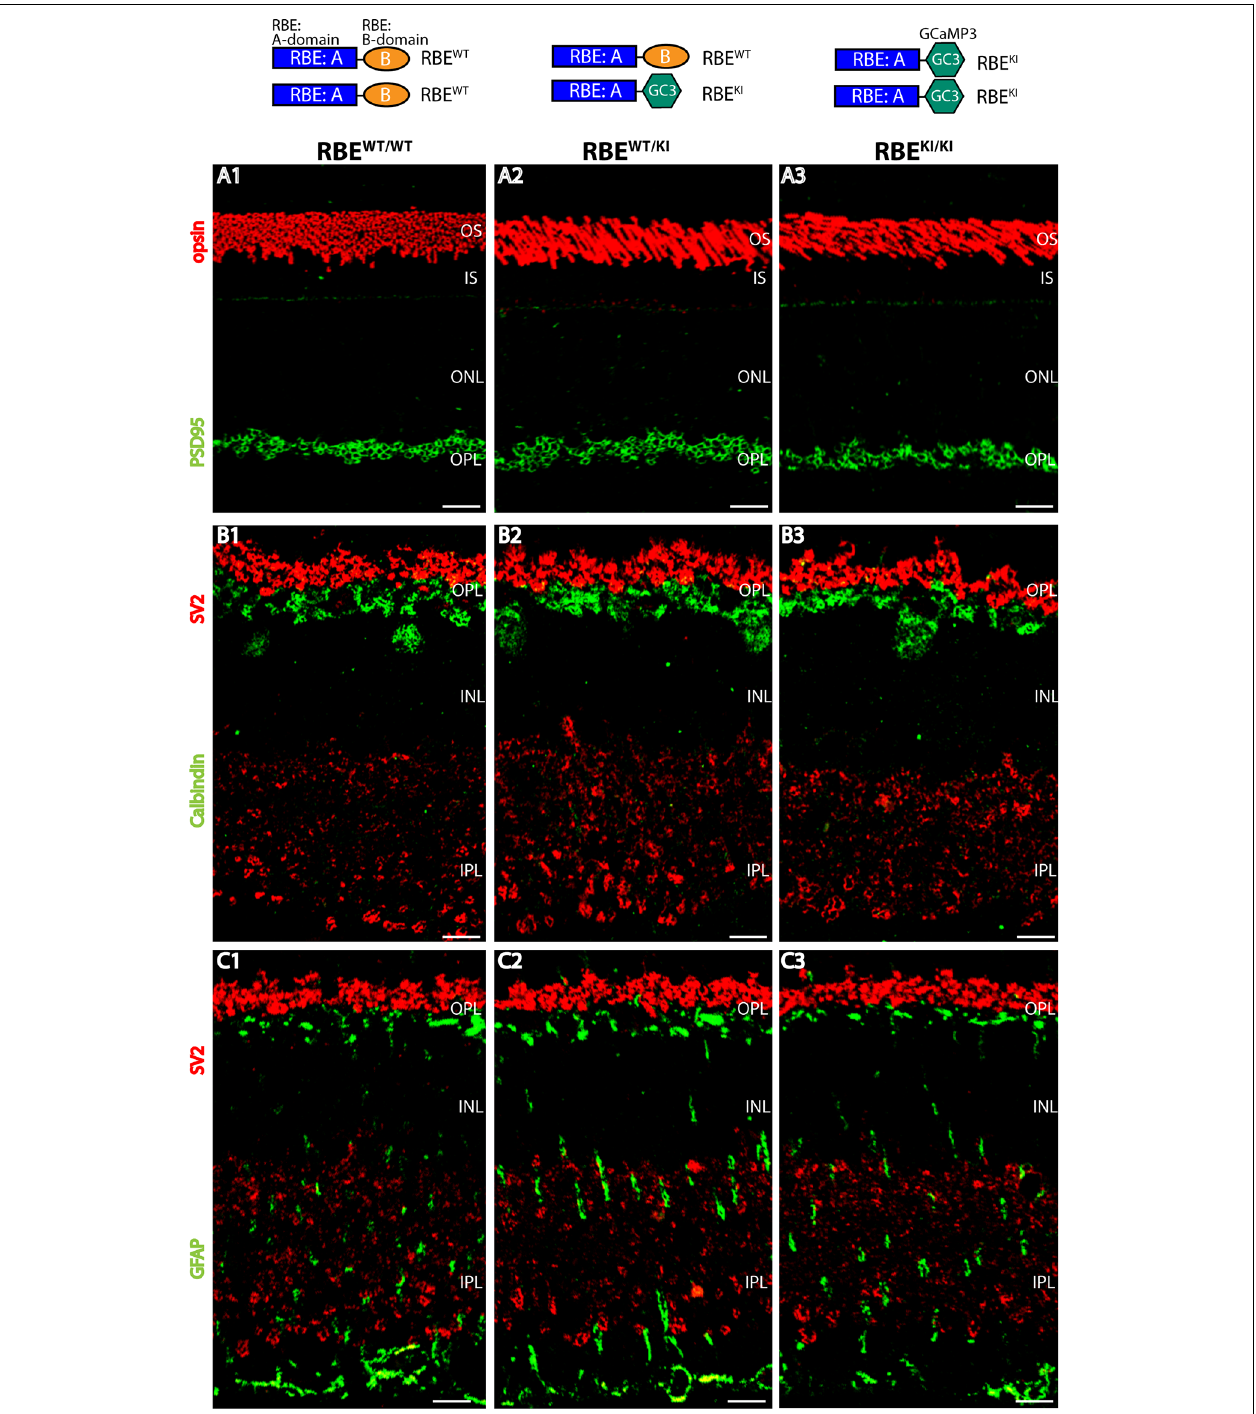
FIGURE 1 | Normal organization of the retina in RIBEYE knockin (KI) mice. The top panel schematically depicts the analyzed genotypes (with the resulting RIBEYE proteins). (A1–A3) Semi-thin sections from the indicated littermate mice (RBE WT/WT , RBE WT/KI , and RBE KI/KI ) were double-immunolabeled with anti-rhodopsin (red, to label photoreceptor outer segments) and anti-PSD95 antibody (green, to label photoreceptor synapses in the OPL. (B1–B3) Retinal semi-thin sections of the indicated genotypes double-immunolabeled with anti-SV2 (red, to label synaptic vesicles in OPL) and anti-calbindin (green, to label horizontal cells in the OPL). (C1–C3) Retinal semi-thin sections of the indicated genotypes double-immunolabeled with anti-SV2 (red, to label synaptic vesicles in OPL) and anti-GFAP (green, to label Müller glia cells). Abbreviations: OS, outer segment; IS, inner segment; ONL, outer nuclear layer; OPL, outer plexiform layer; INL, inner nuclear layer; IPL, inner plexiform layer; RBE, RIBEYE. Scale bar: 5 µ